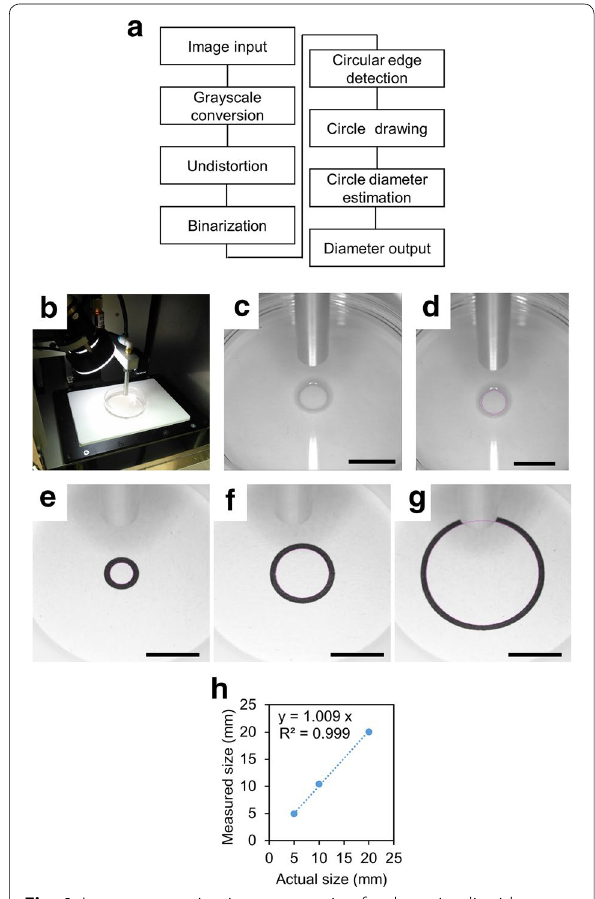
Fig. 4 Image processing instrumentation for detecting liquid- squeezed area and estimating the diameter of a circular shape . a Flowchart of image processing for liquid-squeezed area detection and diameter estimation. Photographs b – d show part of the experi- mental setup, liquid behavior as monitored by the digital camera, and the result of the liquid-squeezed area detection, respectively (see also Additional file 3: Movie 1). Photographs e – g show the detected results of printed circular patterns with diameters of 5, 10, and 20 mm, respectively, for confirming the estimation accuracy. Black scale bars in photographs c – g indicate 1 cm. Graph h shows the relationship between measured and actual sizes of circular patterns. The dotted line in graph h indicates the linear approximation line for data points obtained using the linear regression equation and the coefficient of determination R 2 is